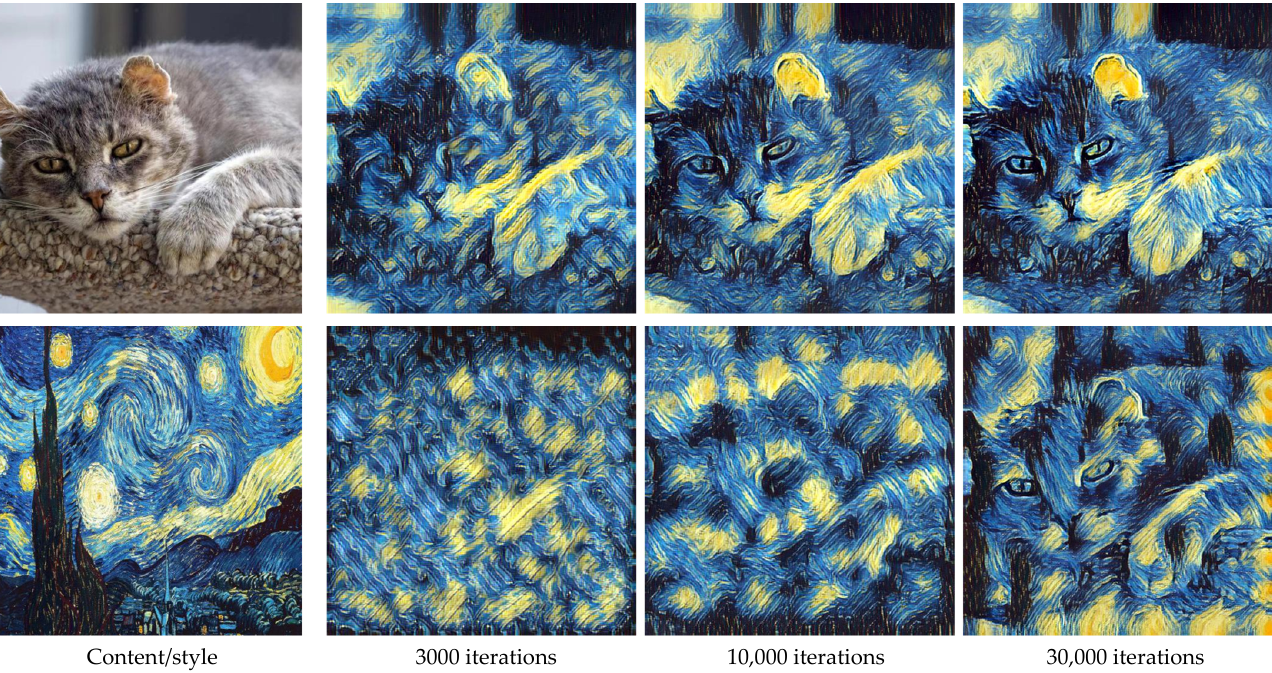
Figure 11. Comparison of stylized images using the full model and the model without the coarse network during training. In the first row, the stylized results are generated by our full model. In the second row, the stylized results are generated by the model without the coarse network.